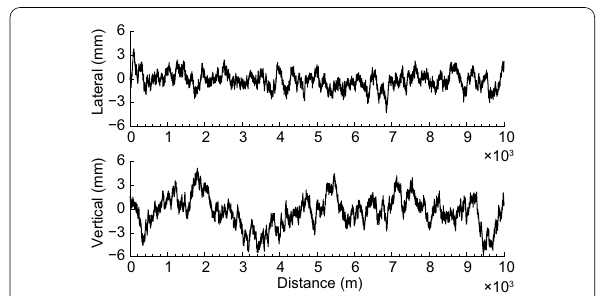
Fig. 3 A sample of the aided INS positioning error process in the lateral and vertical directions